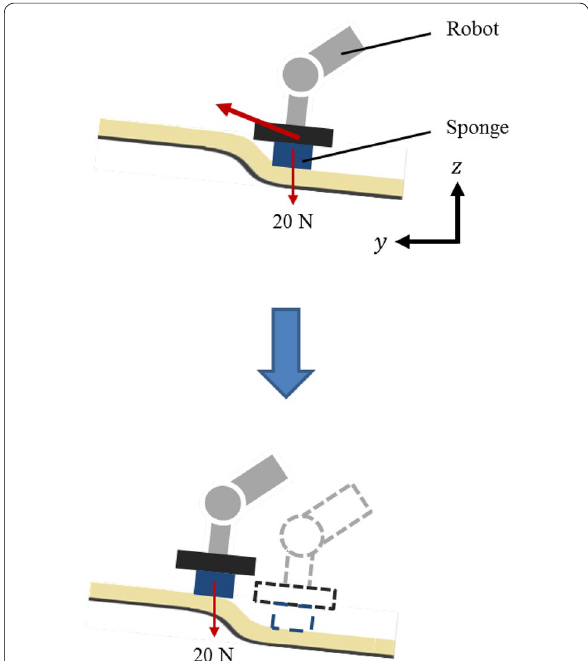
Fig. 13 The rubbing motion using the manipulator